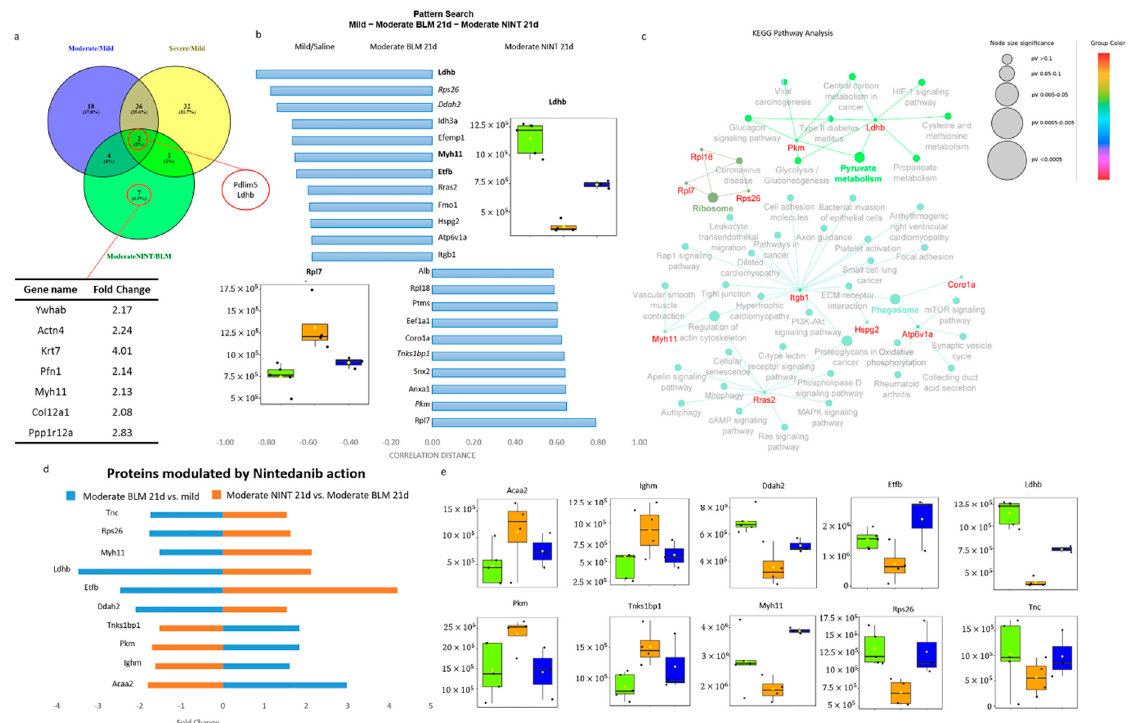
Figure 5. Nintedanib-mediated fibrosis slowdown. ( a ) Venn diagram comparing statistically significant proteins ( p -value adj ≤ 0.05, Fold Change ≥ 2 or ≤− 2) in the comparisons of moderate BLM vs. mild/ severe BLM vs. mild/moderate NINT 21d vs. moderate BLM 21d; the two proteins common to all pairwise comparison are circled in red; and the even proteins are statistically significant ( p -value adj ≤ 0.05, fold change ≥ 2 or ≤− 2) only in the comparison moderate NINT 21d vs. moderate BLM 21d are listed in a table. ( b ) Pattern search analysis of the proteins with a statistically significant ( p -value ≤ 0.05) correlation pattern and modulated (increased or decreased) by NINT treatment in the comparison between mild (green), moderate BLM 21d (orange), and moderate NINT 21d (blue), the correlation distance value in the bar chart is expressed based on the pattern search 1 ‐ 2 ‐ 1. ( c ) Cytoscape network of KEGG pathways obtained including the analysis of all 22 proteins with a statistically significant correlation. ( d ) Ten proteins with a reversing fold change in the comparison between moderate ‐ BLM 21d vs. mild and moderate ‐ NINT 21d vs. moderate ‐ BLM 21d ( p ‐ value adj ≤ 0.05, FC ≥ 1.5 or ≤− 1.5). ( e ) Boxplots of the ten proteins. In all boxplots, mild/saline boxes are colored in green, moderate BLM 21d in orange, and moderate NINT 21d in blue. BLM—bleomycin; NINT—nintedanib; and d—days. In all Boxplots, black dots represent the abundance of the selected features in all samples, yellow diamond represents the mean abundance.